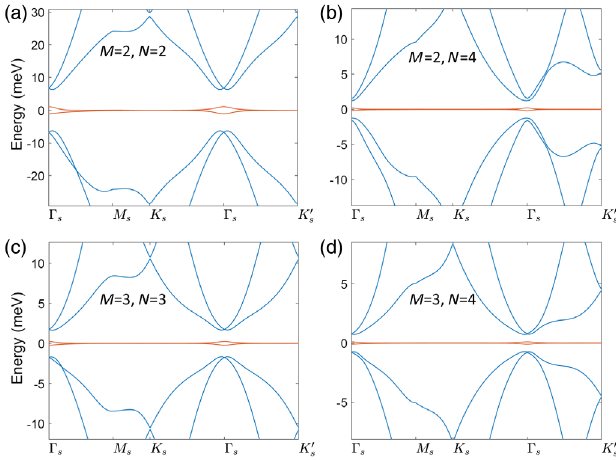
FIG. 2. The band structures of ( M þ N )-layer twisted multi- layer graphene at the first magic angle θ ¼ 1 . 05 °. (a) M ¼ 2